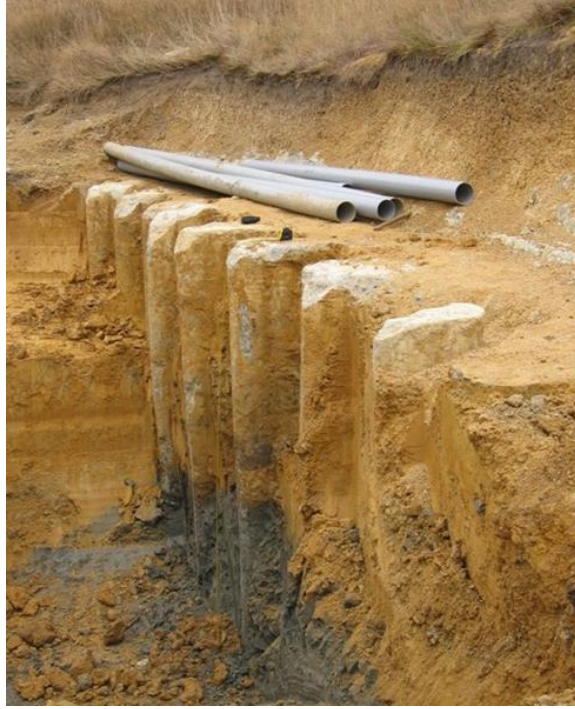
Figure 4. Vertical lime-cement columns – technology COLMIX